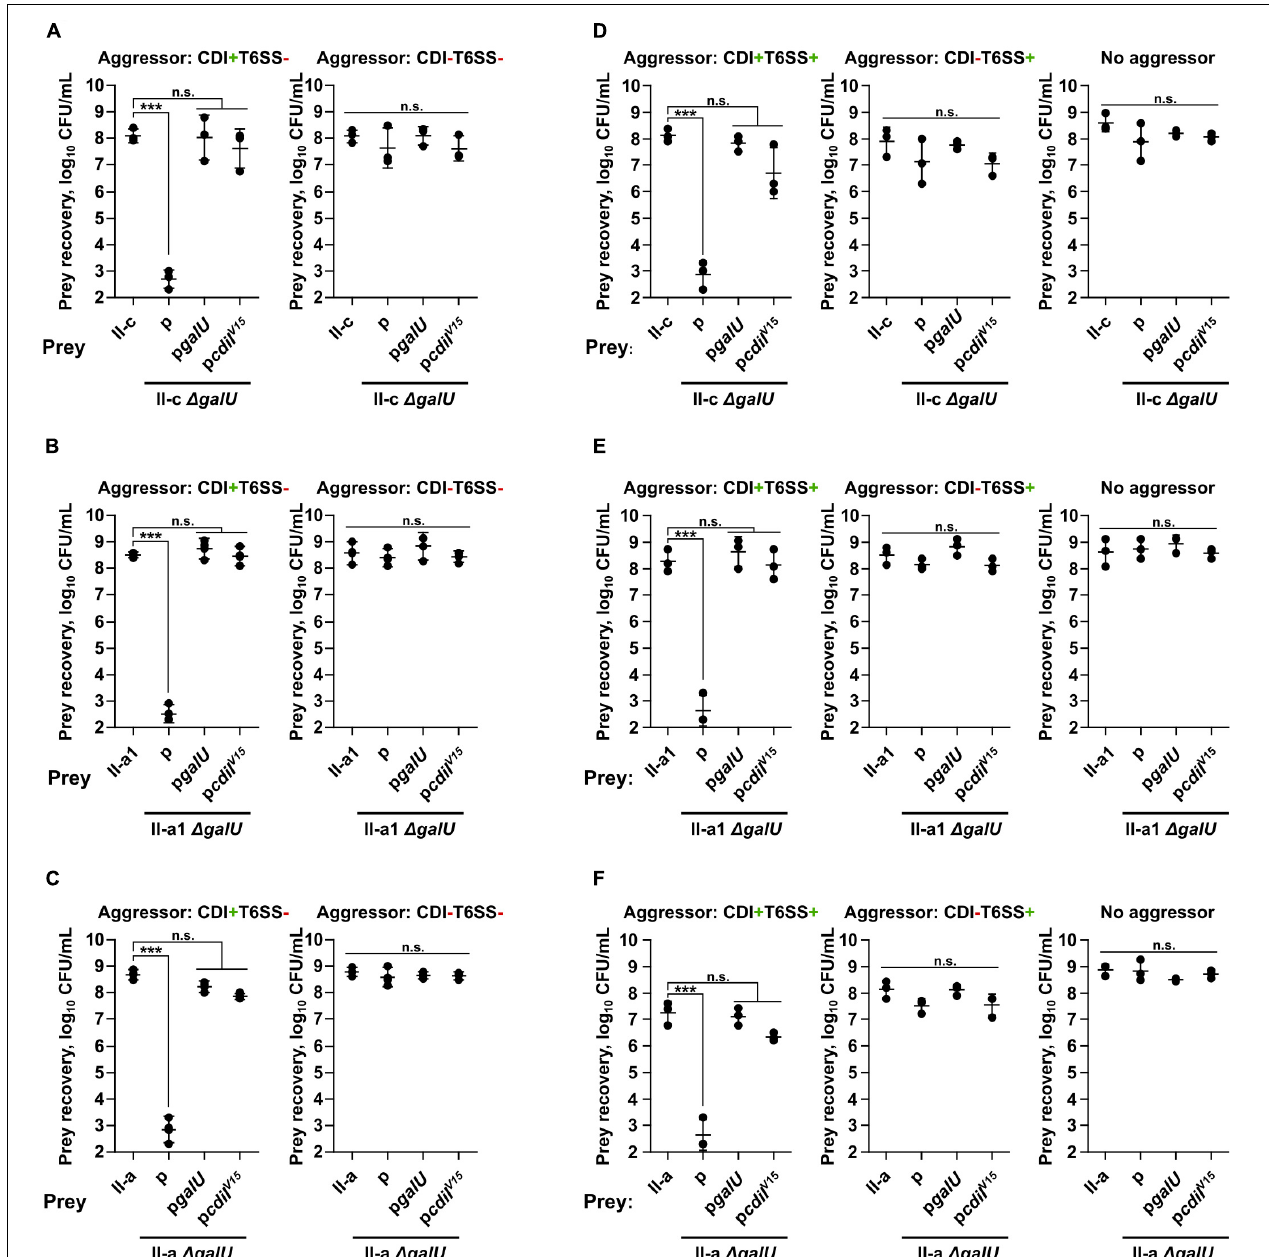
FIGURE 2 | Quantitative evaluation of inter-bacterial competition. Graphs show recovered numbers of A. baumannii clinical strains after being premixed with an aggressor at the aggressor:prey ratio of 1:1. A. baumannii clinical strains II-c (A,D) , II-a1 (B,E) , and II-a (C,F) , their galU mutants, and galU mutants complemented with either wild-type galU gene or immunity cdiI V15 gene from the A. baumannii V15 strain were used as prey. Competitions were performed with the following A. baumannii V15 mutants used as the aggressors: (cid:49) bfmRS (cid:49) hcp (CDI + T6SS - ) (A–C) (cid:49) bfmRS (cid:49) hcp (cid:49) cdi V15 (CDI - T6SS - ) (A–C) , (cid:49) bfmRS (CDI + T6SS + ) (D–F) , (cid:49) bfmRS (cid:49) cdi V15 (CDI - T6SS + ) (D–F) . E. coli DH5 α was used as a negative non-competitive control to enumerate bacteria numbers if there was no competition. Error bars represent standard deviation. Horizontal lines represent mean value. Values were calculated from three independent experiments. Statistically significant differences are indicated by three asterisks (One-way ANOVA, p < 0.001); n.s., not significant.